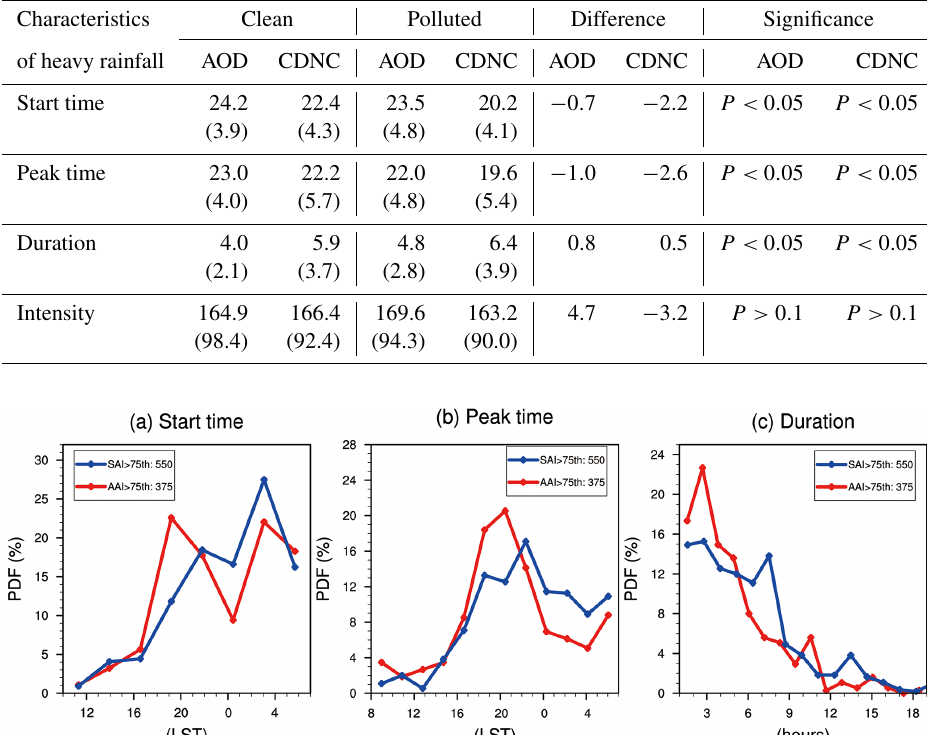
Figure 4. PDFs of (a) start time (units: LST), (b) peak time (units: LST), and (c) duration (units: hours) of heavy rainfall on the days with SAI more than the 75th percentile (blue lines, data from OMI) and days with AAI more than the 75th percentile (red lines, data from OMI), during early summers from 2005 to